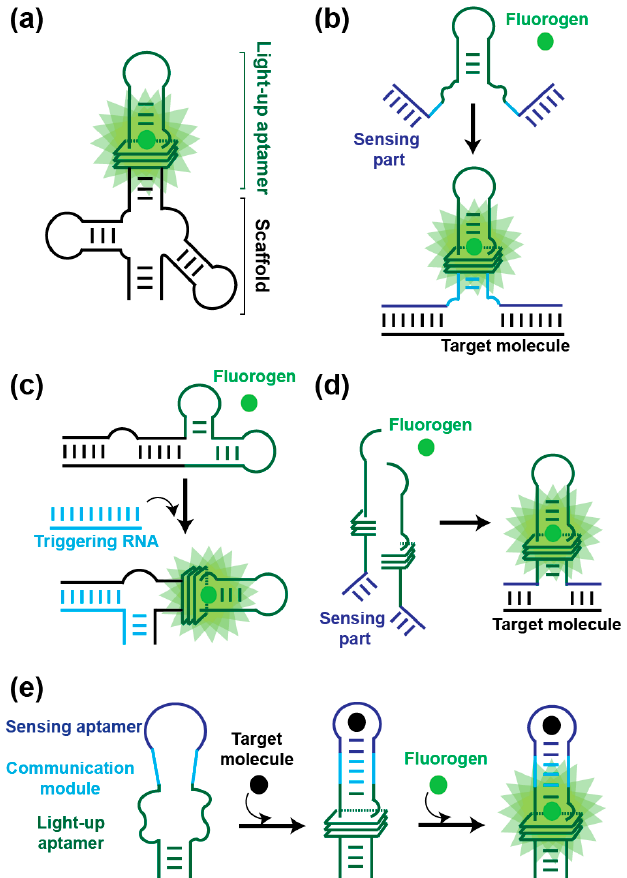
Figure 4. Light-up aptamers engineering and uses thereof. ( a ) Light-up RNA aptamers can be embedded into a scaffold RNA (here a tRNA) to improve folding efficiency and resistance to RNases [29,61]. The construct can either be directly expressed from an independent promoter or inserted into the sequence of a target mRNA. ( b ) Light-up aptamer sensing a target RNA in trans [77,78]. A key helix (light blue) of the light-up aptamer is engineered to weaken the structure of the RNA and destabilized the fluorogen-binding site. Furthermore, sequences complementary to the target nucleic acid (acting as a sensing part) are appended to both ends of the molecule (dark blue). Upon binding to the target molecule (in black), the structure of the light-up moiety is stabilized and its fluorogen-binding capacity is restored, leading to fluorescence emission (green shadow). ( c ) Light-up aptamer sensing a target RNA in trans via strand displacement [79–81]. Sequences are appended to both ends of the light-up aptamer and induce an alternative folding preventing the interaction of the aptamer with the fluorogen. However, the binding of the target RNA to the construct induces a conformational change restoring the structure of the light-up aptamer moiety and its fluorogen-binding capacity, leading to fluorescence emission (green shadow). ( d ) Sensing target nucleic acids using split light-up aptamers [82,83]. The aptamer is split into two halves, each possessing a sequence complementary to the target nucleic acid (acting as a sensing part, in dark blue). Whereas both halves cannot form a functional aptamer in the absence of the target nucleic acid, the presence of the latter drives the productive association of both molecules into a functional light-up aptamer able to emit fluorescence. ( e ) Allosteric light-up RNA aptamer [84,85]. The light-up aptamer is engineered to weaken the structure of the RNA and destabilize the fluorogen-binding site. Moreover, the sequence of a sensing aptamer (in dark blue) is inserted into that of the light-up aptamer via a communication module (in light blue). Upon the interaction of the sensing aptamer with a target molecule (e.g., a metabolite or a protein), the structure of the light-up aptamer is stabilized and its fluorogen-binding capacity is restored. Note that all the examples are shown with the Spinach aptamer, but these concepts can be extended to any other light-up